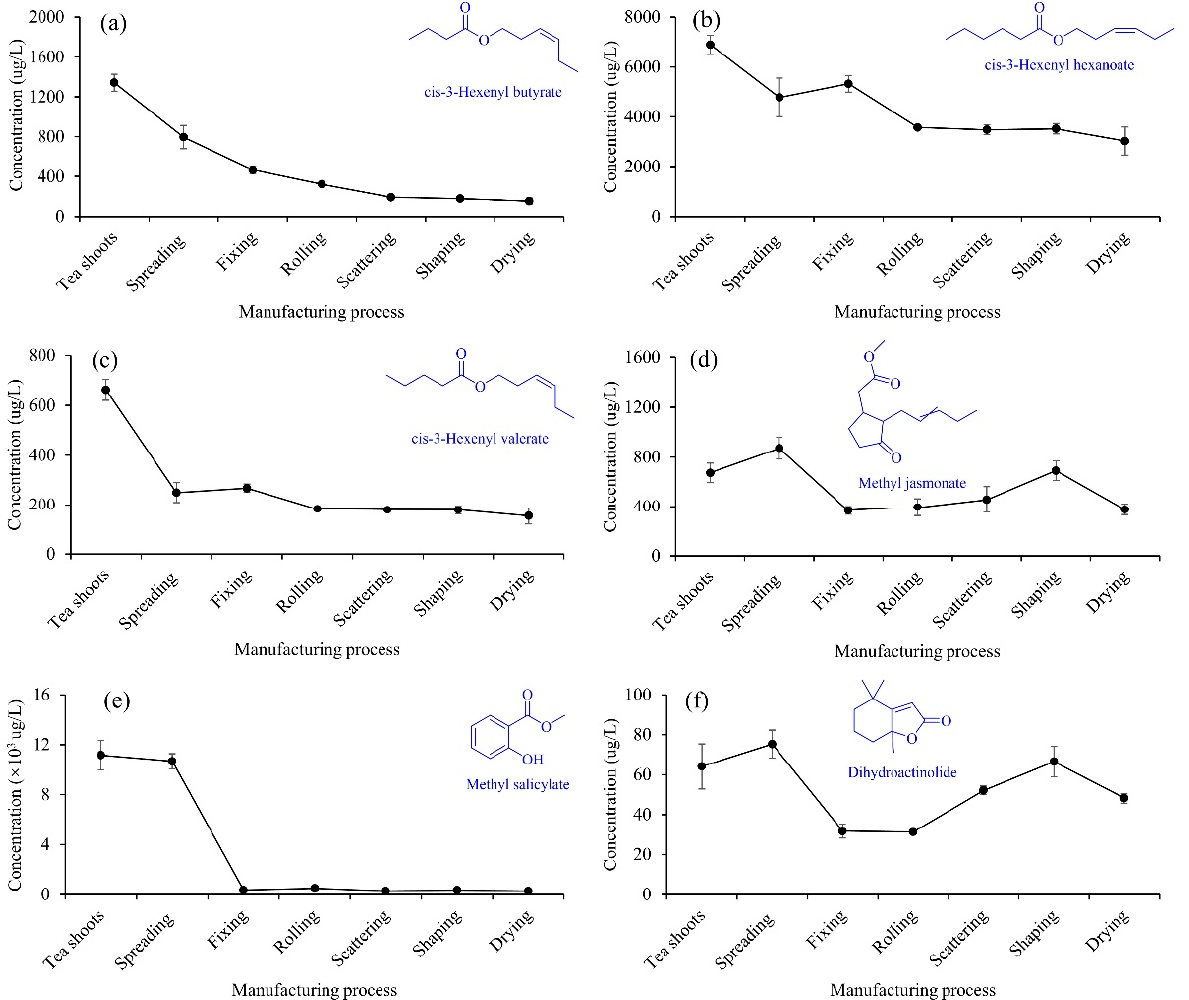
Figure 4. Changes in the concentrations of cis-3-hexenyl butyrate ( a ), cis-3-hexenyl hexanoate ( b ), cis-3-hexenyl valerate ( c ), methyl jasmonate ( d ), methyl salicylate ( e ) and dihydroactinolide ( f ) during the XYMJ green tea manufacturing.